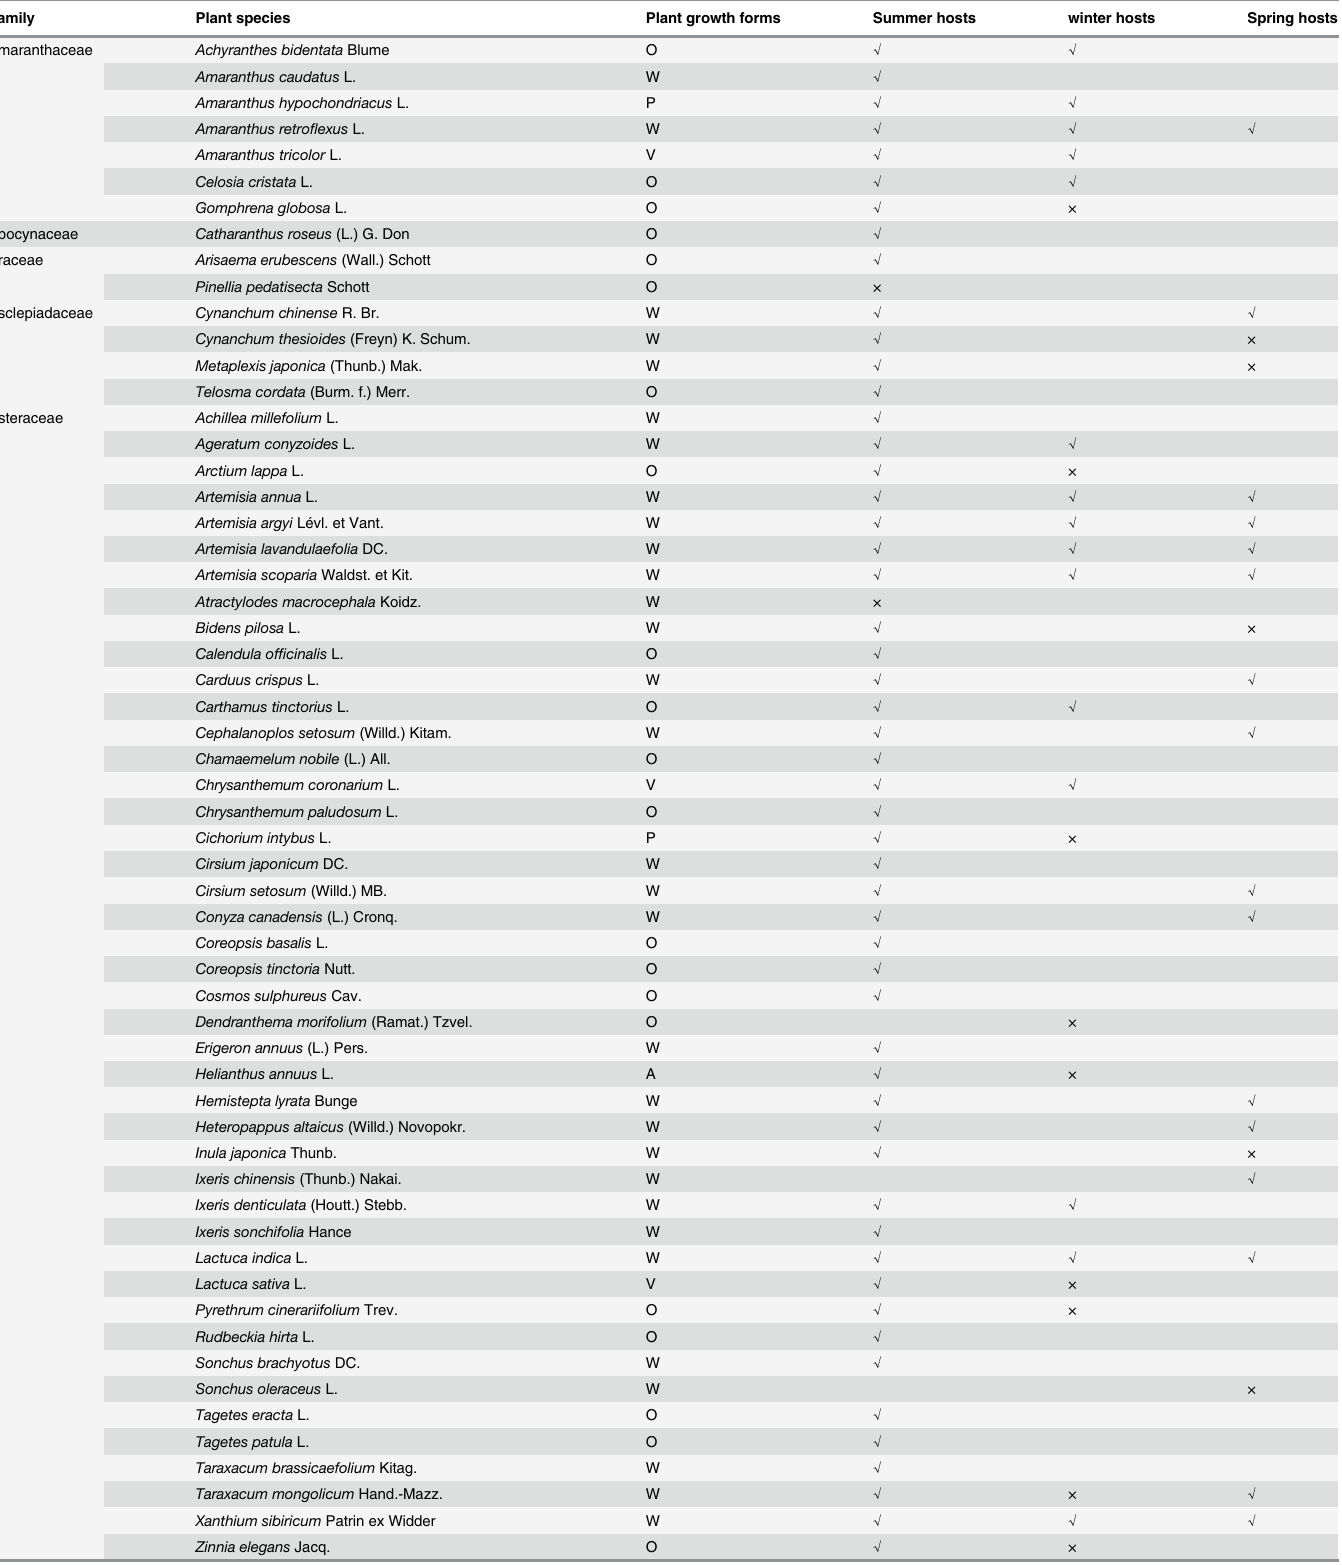
W √ Sonchus oleraceus L. W × Tagetes eracta L. O √ Tagetes patula L. O √ Taraxacum brassicaefolium Kitag. W √ Taraxacum mongolicum Hand.-Mazz. W √ × √ Xanthium sibiricum Patrin ex Widder W √ √ √ Zinnia elegans Jacq. O